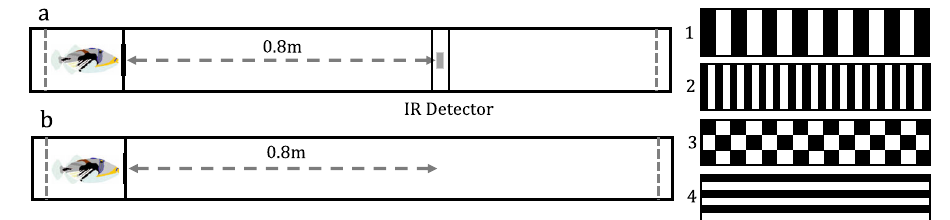
Fig. 1 Testing the role of optic fl ow in distance estimation: training and testing set-up. a Training — the fi sh was trained to swim 0.8 m to an overhead infrared proximity sensor (IR Detector) which when the fi sh passed beneath it, detected a voltage change and via the Arduino computer caused the aquarium lights to switch on, signalling to the fi sh to return to the start area for a food reward. Training was conducted with the tunnel walls and fl oor patterned with alternating 0.02-m-wide black and white vertical stripes (set-up 1). b Testing — during testing trials, the infrared proximity sensor controlling the overhead lights was removed. The fi sh was therefore unable to cause the lights to turn on during testing trials. This was to test whether the fi sh had learned the correct distance, or to swim to the infrared detector landmark to encounter the light stimulus. The fi sh was tested with four different background combinations: (1) 0.02 m vertical stripes; (2) 0.01 m vertical stripes; (3) 0.02 m wide checkerboard pattern; (4) horizontal stripes of width 0.02 m.